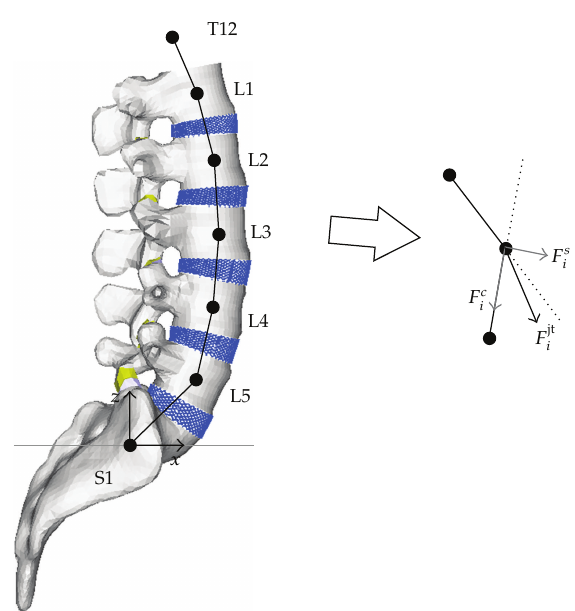
jt i into the compressive force F